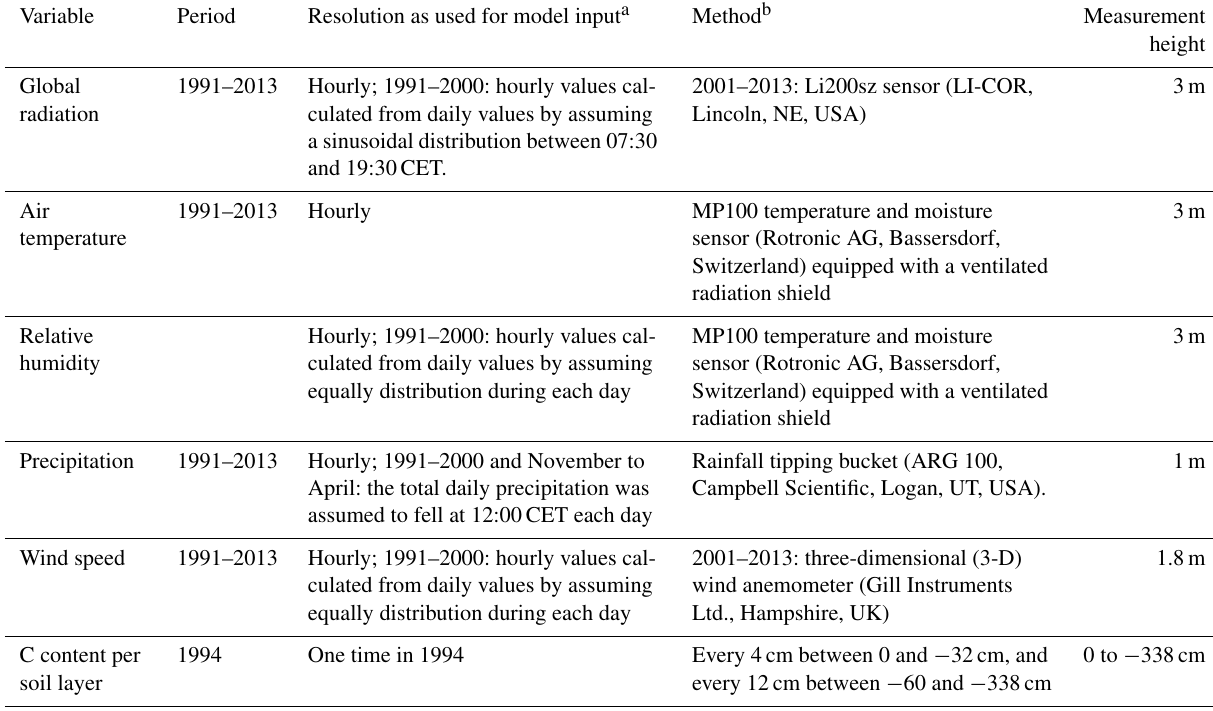
Table 1. Measurement data used as model